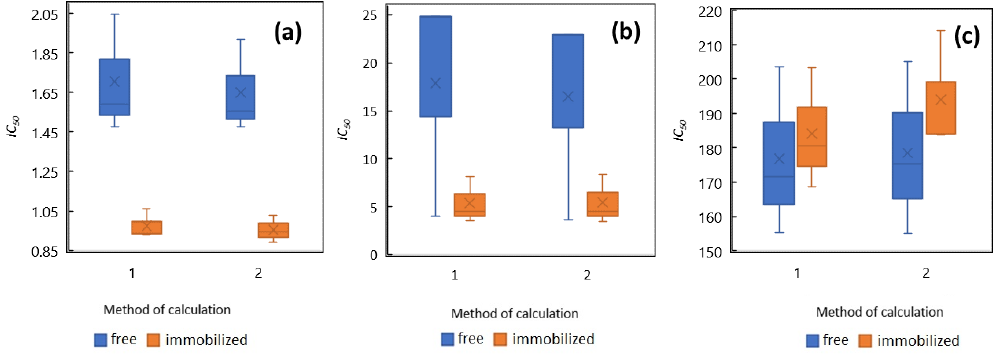
Figure 4. Experimentally measured IC 50 on R. subcapitata (right axis). ( a ) K 2 Cr 2 O 7 in mg·L − 1 ; ( b ) TCS in µg·L − 1 ; ( c ) DCF in mg·L − 1 .